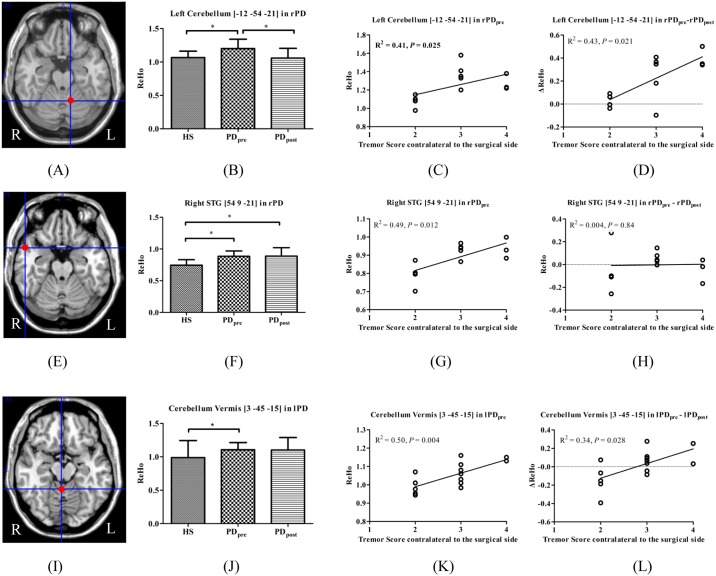
Brain areas which demonstrated altered ReHo relative to HS and correlated with tremor.(A) left cerebellum_4_5 in rPD; (E) right STG in rPD; (I) cerebellum vermis_3 in lPD; (B, F, J) ReHo among HS, PDpre, and PDpost; (C, G, K) ReHo in PDpre correlated with tremor; (D, H, L) ΔReHo correlated with tremor.